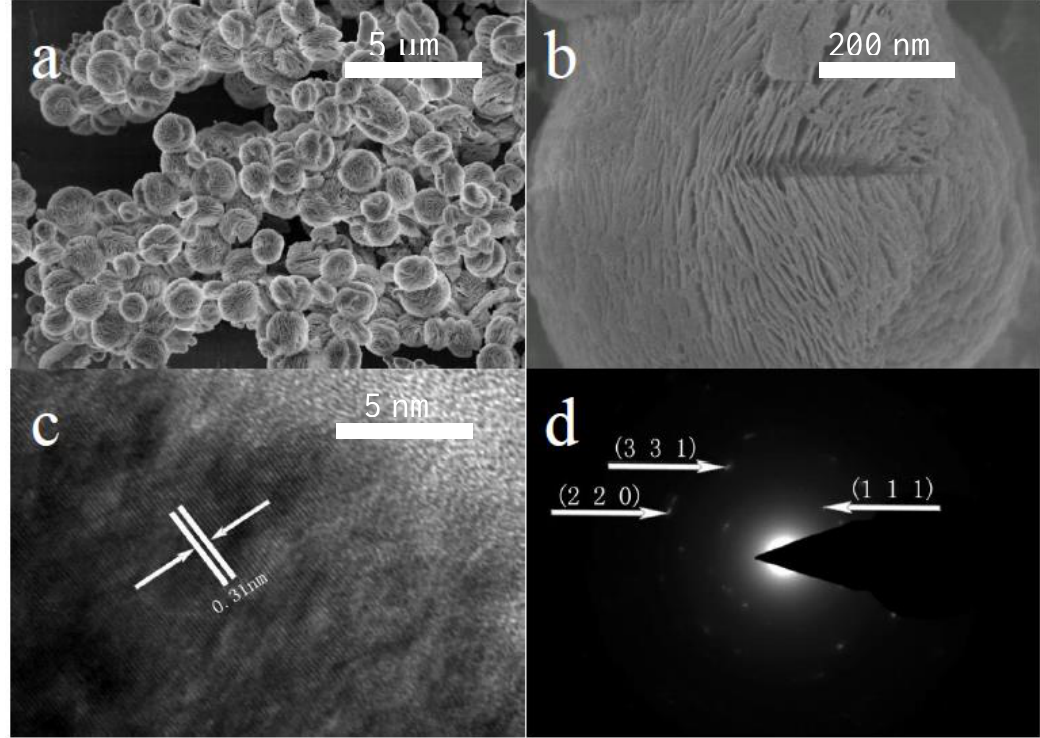
Figure 2. ( a , b ) SEM images, ( c ) HRTEM image, and ( d ) SAED pattern of the 3D hierarchical structured CeO 2 .